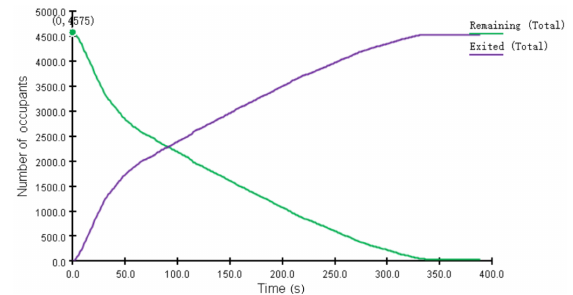
Fig. 6 Relationship between evacuees in the canteen and evacuation time.